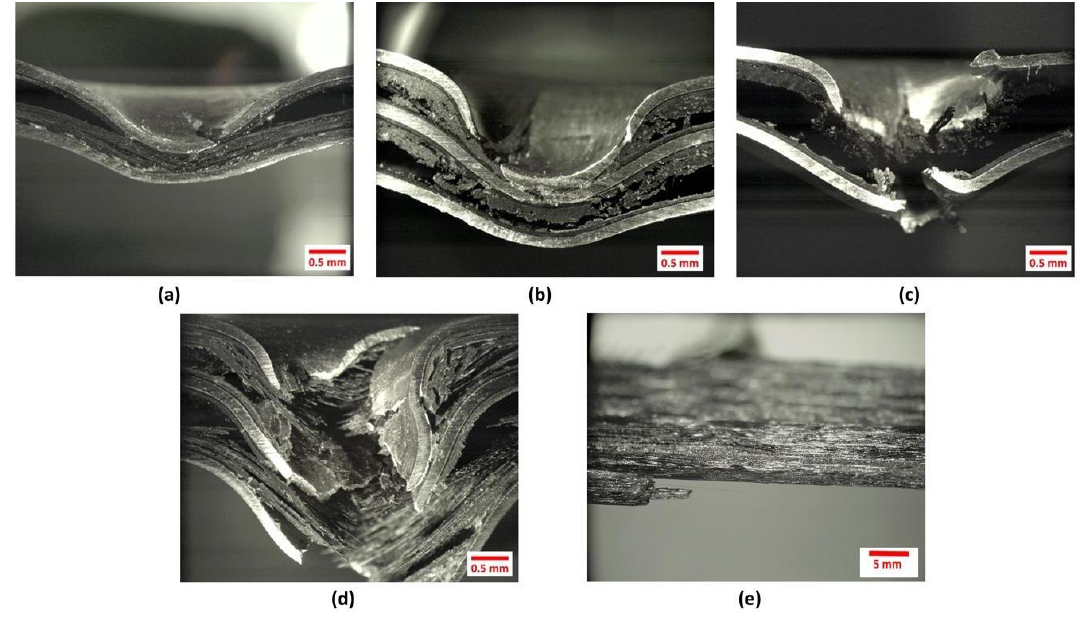
Figure 16. High velocity impacted samples. ( a ) FML 2 / 1 at 176 m / s ( b ) FML 3 / 2 at 273 m / s ( c ) Perforated FML 2 / 1 ( d ) Perforated FML 3 / 2 ( e ) Perforated plain composite.